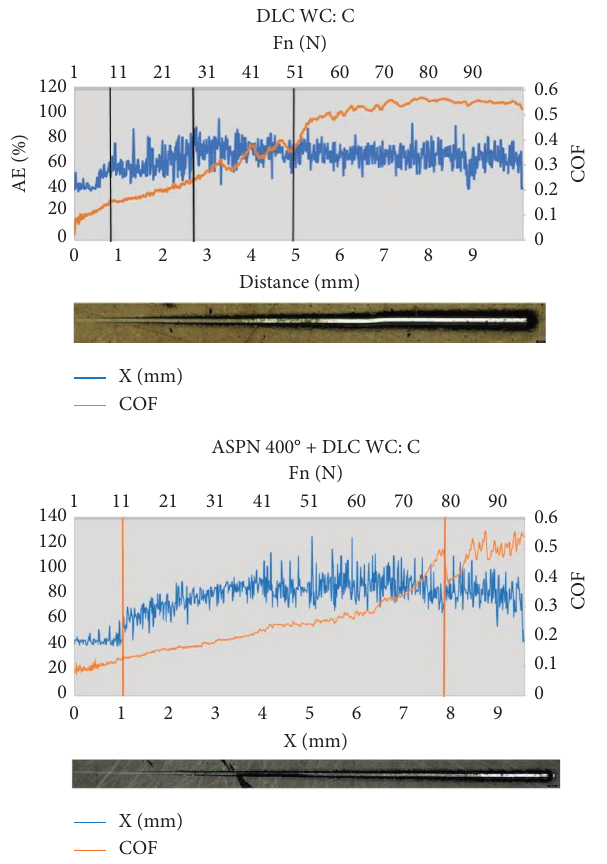
Figure 5: Acoustic emission evolution of DLC coating and ASPN with pretreatment at 400 ° C+ DLC WC:C (COF: blue plot and AE: orange plot) vs. the indenter displacement. (a) DLC WC: C. (b) ASPN 400 ° C+DLC WC :C.